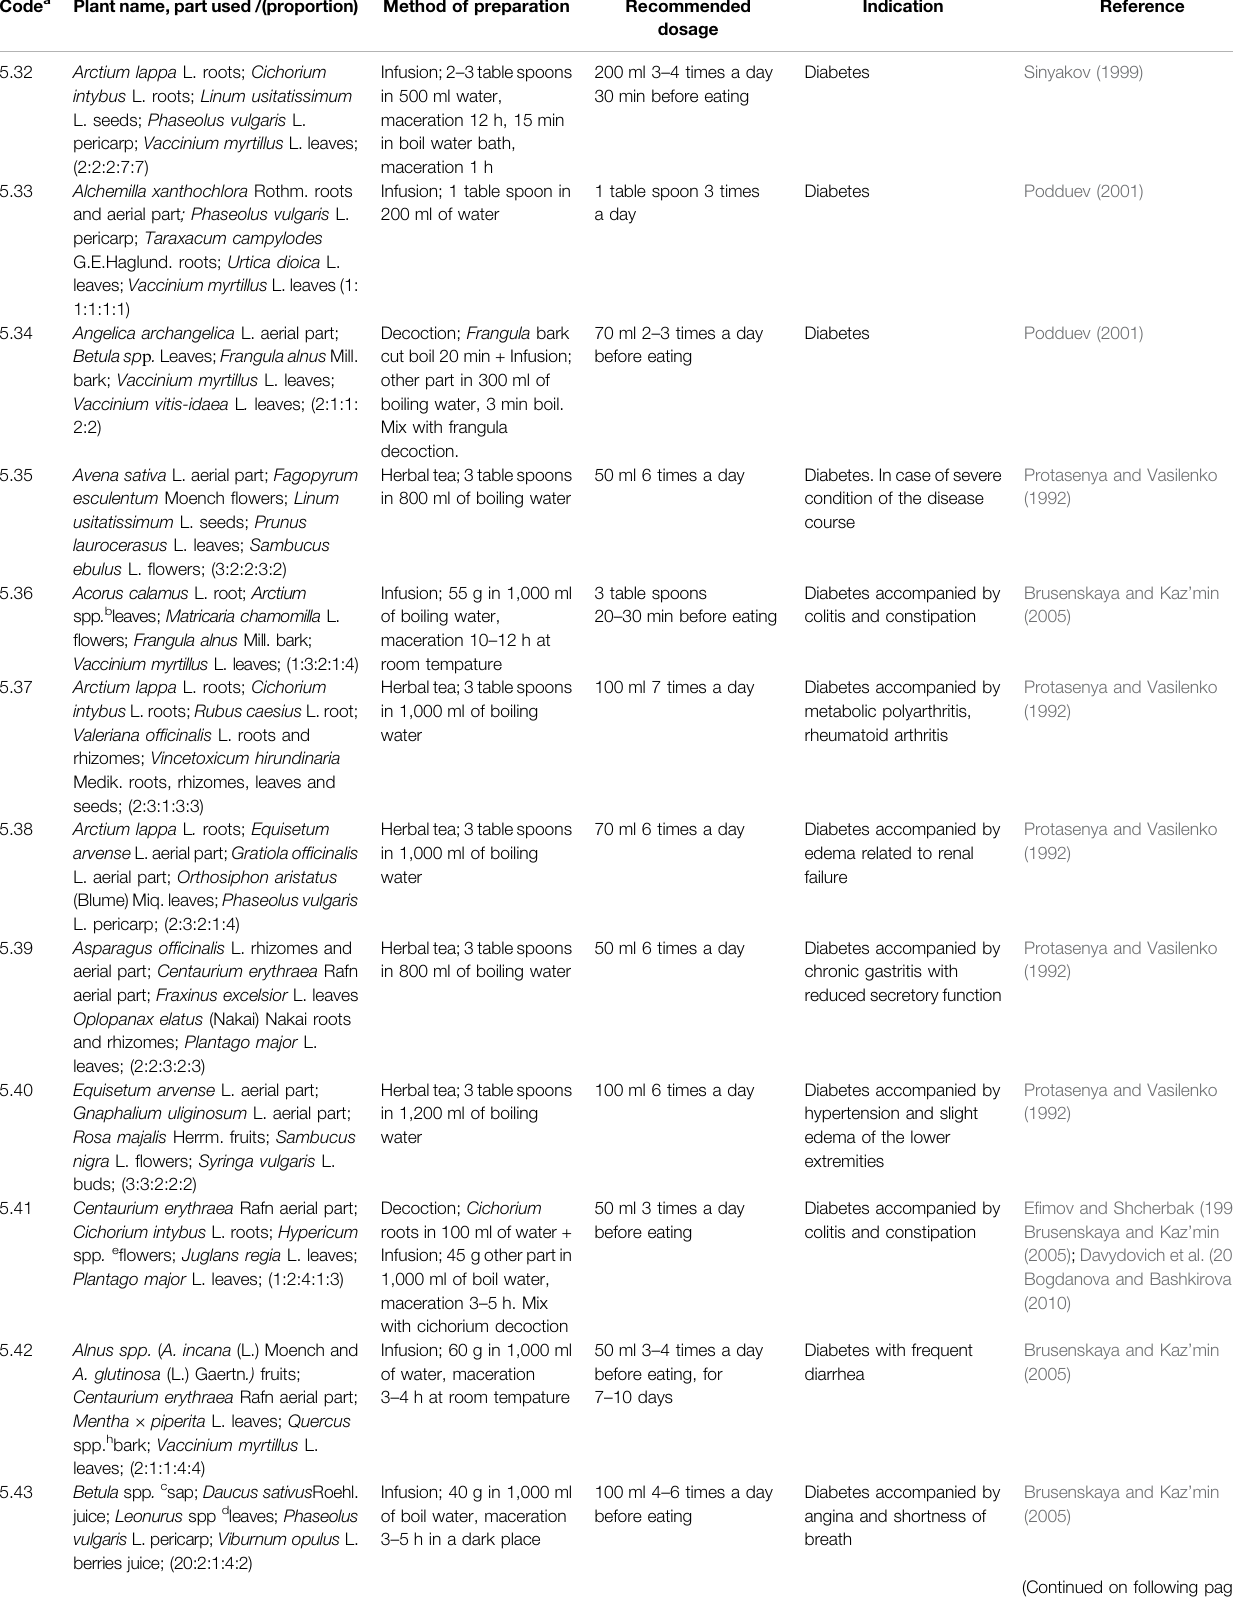
TABLE 1 | ( Continued ) The list of medical species used for the management of diabetes and related disorders in Russia. Code a Plant name, part used /(proportion) Method of preparation Recommended